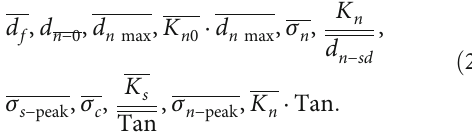
Figure 4: Spatial distributions of pressure fi elds of the prototype and the